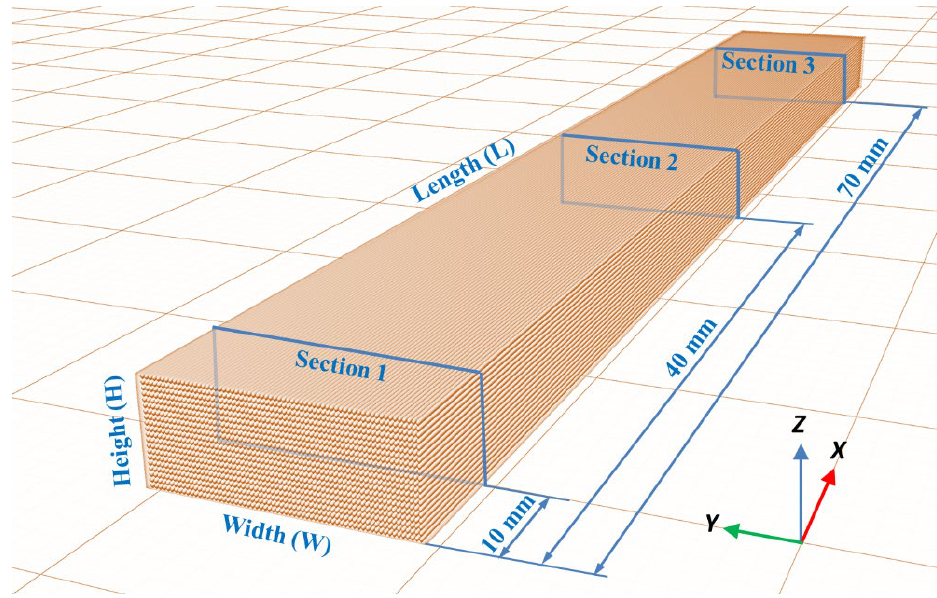
Figure 3. Measured sections in each specimen.